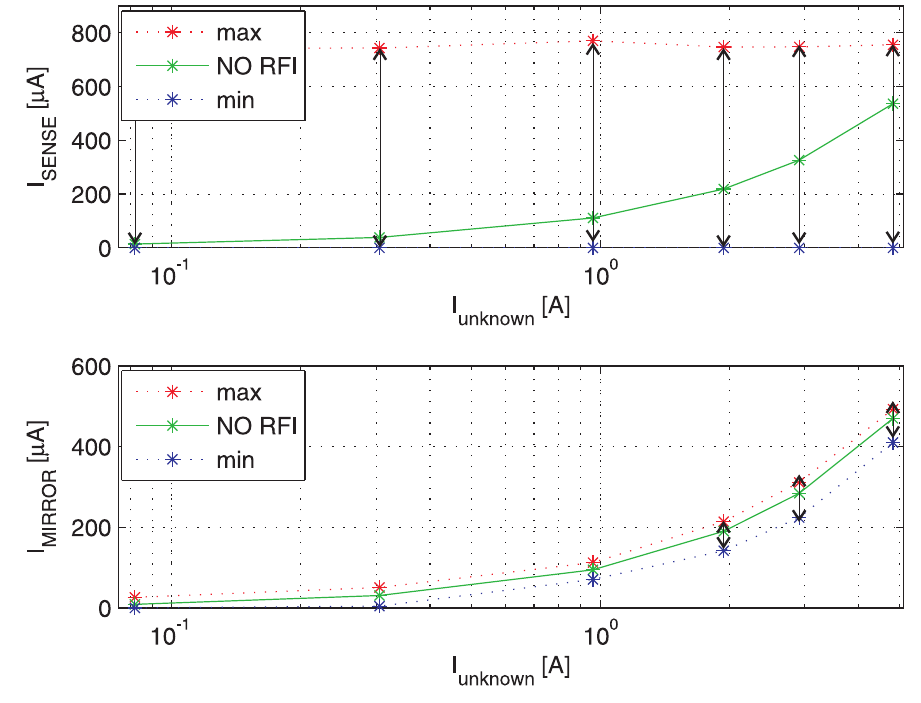
Figure 12. Maximum and minimum current-sensing of the traditional SenseFET current sensor ( I ) and the new sensor based on the Miller effect ( I SENSE sense I . CW RFI current amplitude 200 mA @ 400 D